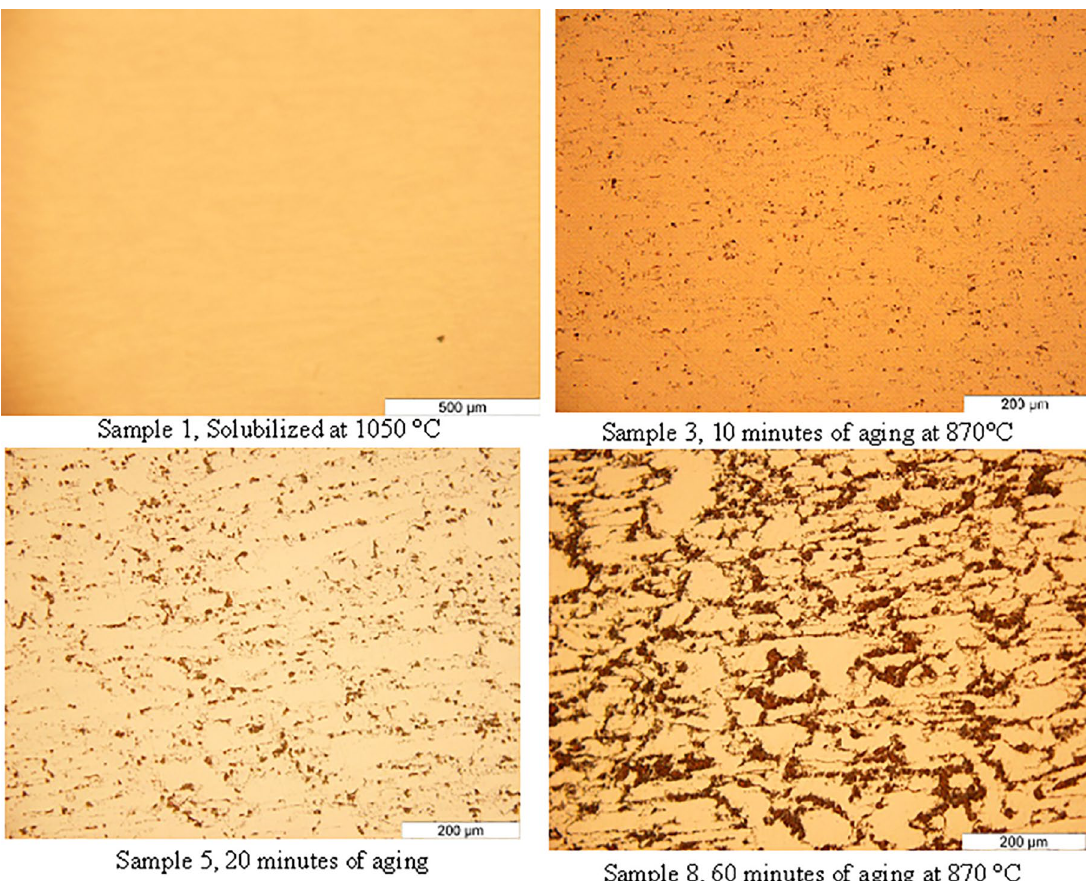
Figure 2. Duplex Stainless Steel microstructure subjected to different heat treatment times. Electrolytic etching with KOH 10% at 60 s.